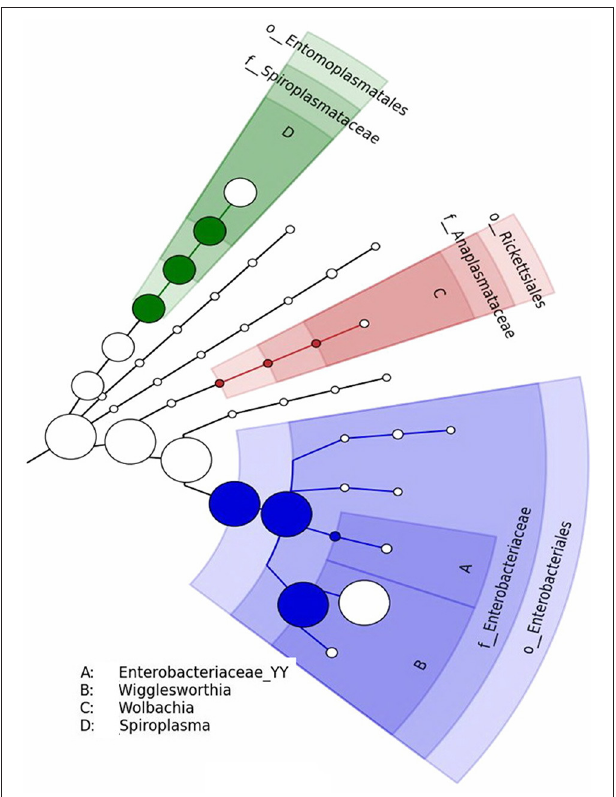
FIGURE 7 | Phylogenetic diversity of bacterial 16S rRNA sequences found in sample 20 (infected tsetse fly midguts from Bipindi).